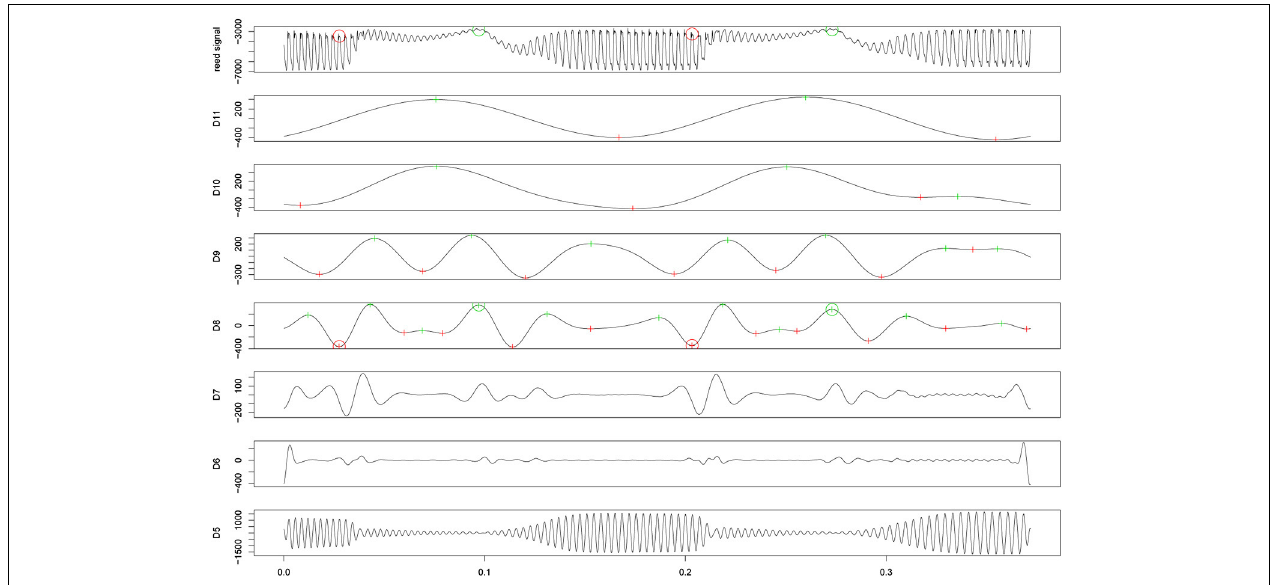
FIGURE 4 | Maximal Overlap Discret Wavelet Transform of a sensor reed signal containing tongued articulation: the figure shows the input signal (top) including detected landmarks (TRC: red circle, TRR: green circle)